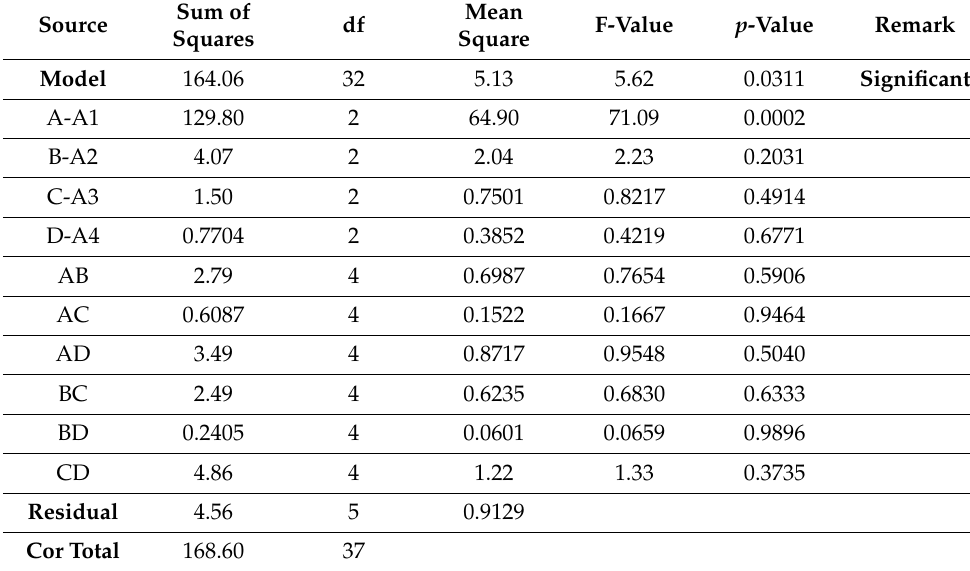
Table 2. Particle size ANOVA Response for 2FI model for the prepared Saxagliptin SLNs.